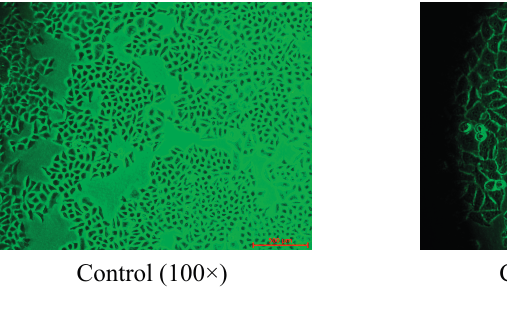
Figure 5. Cellular morphology.